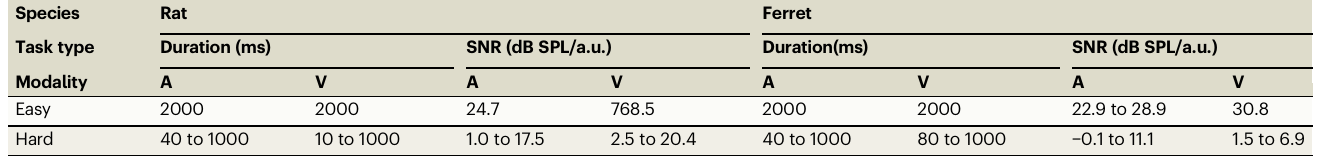
Table 3 | Summary of stimuli used for all behavioural testing Species Rat Ferret Task